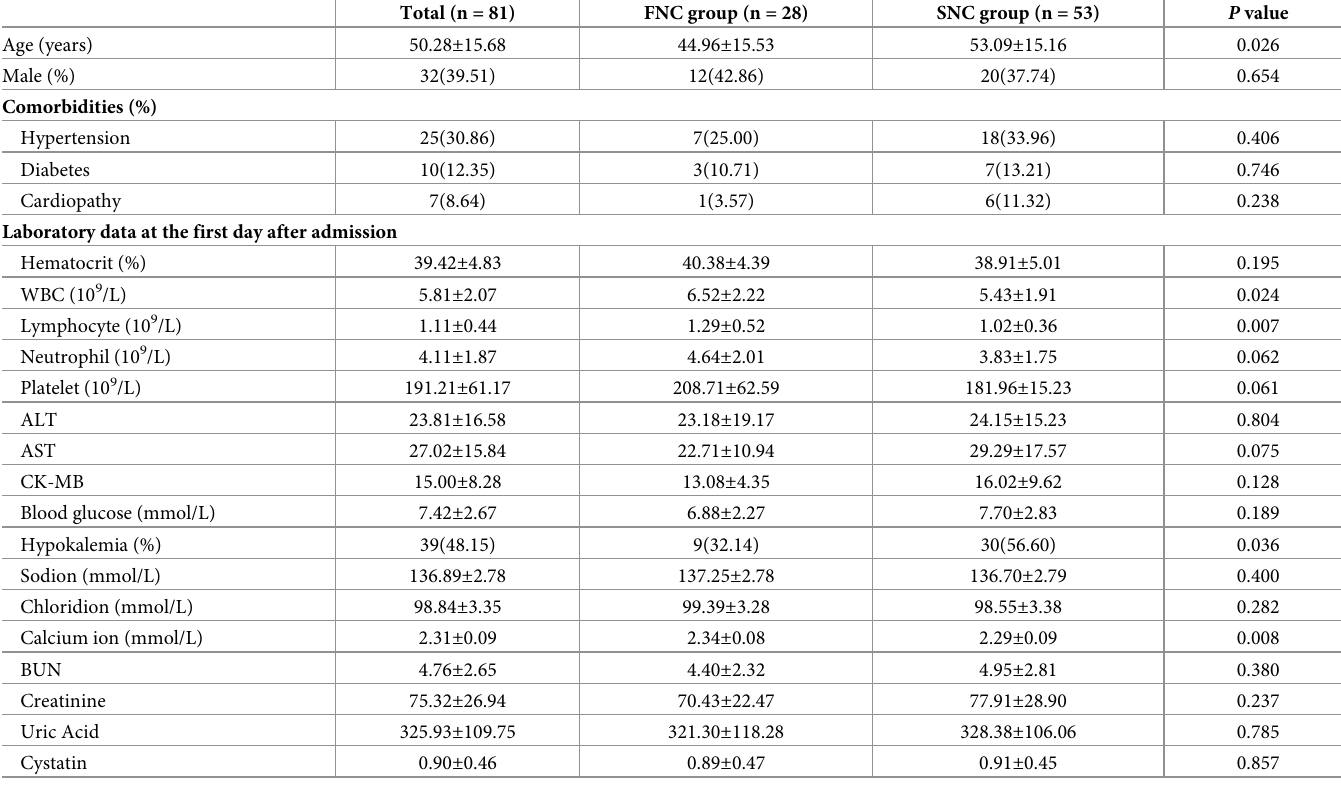
Table 2. Data of the included patients with moderate COVID-19 in FNC group and SNC